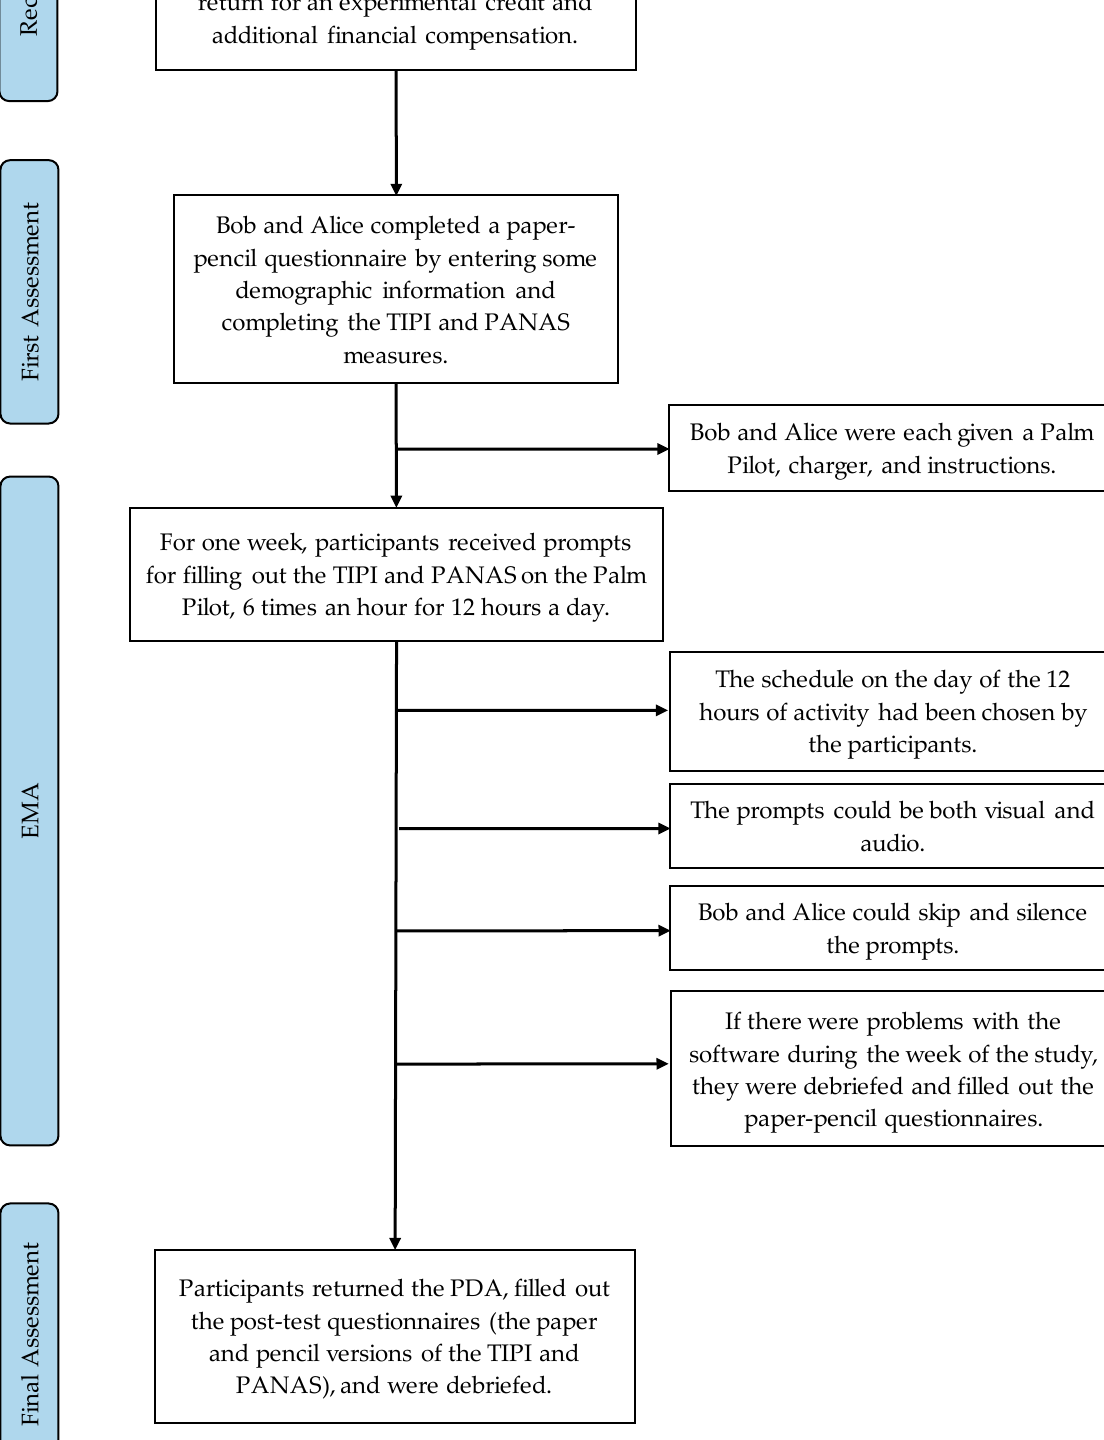
Figure 1. Flowchart illustrating the research technique.